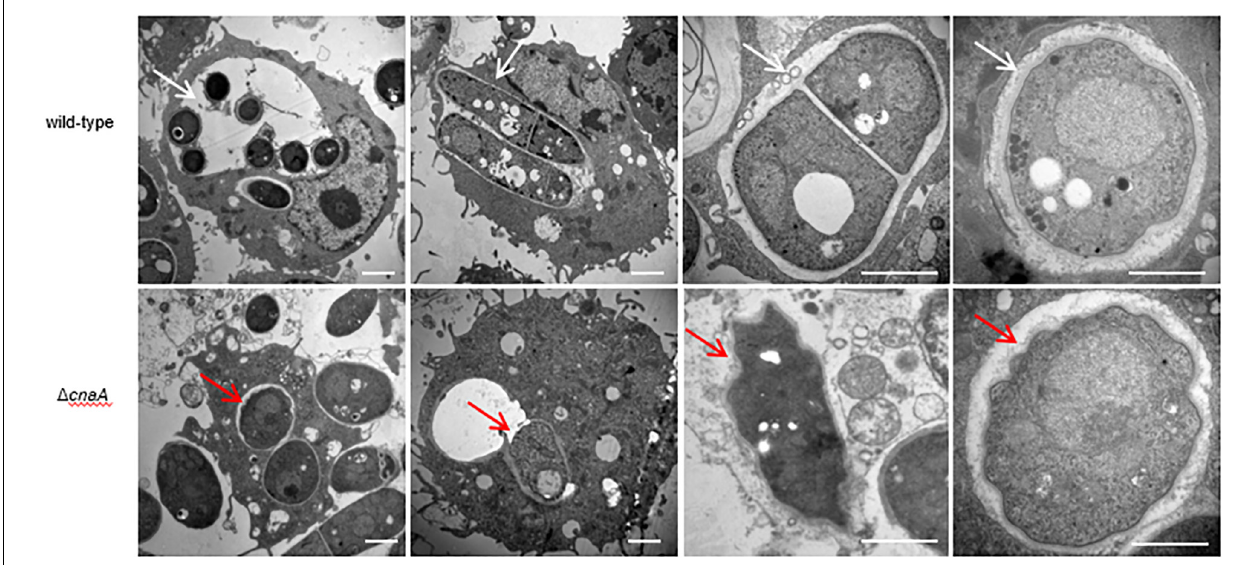
FIGURE 7 | The cnaA gene is essential for survival in macrophages. Wild-type and (cid:49) cnaA strains were co-cultured with RAW264.7 macrophages and observed by TEM. Wild-type conidia germinated into yeast cells and maintained cellular integrity and morphology after 24 h. The septum of dividing cells is clearly visible, the cell wall is complete and uniform, and organelles are distinct (white arrow). In contrast, most of the (cid:49) cnaA mutant conidia failed to germinate or were clearly atrophic with little to no organellar integrity (red arrow). Scale bars, 2 µ